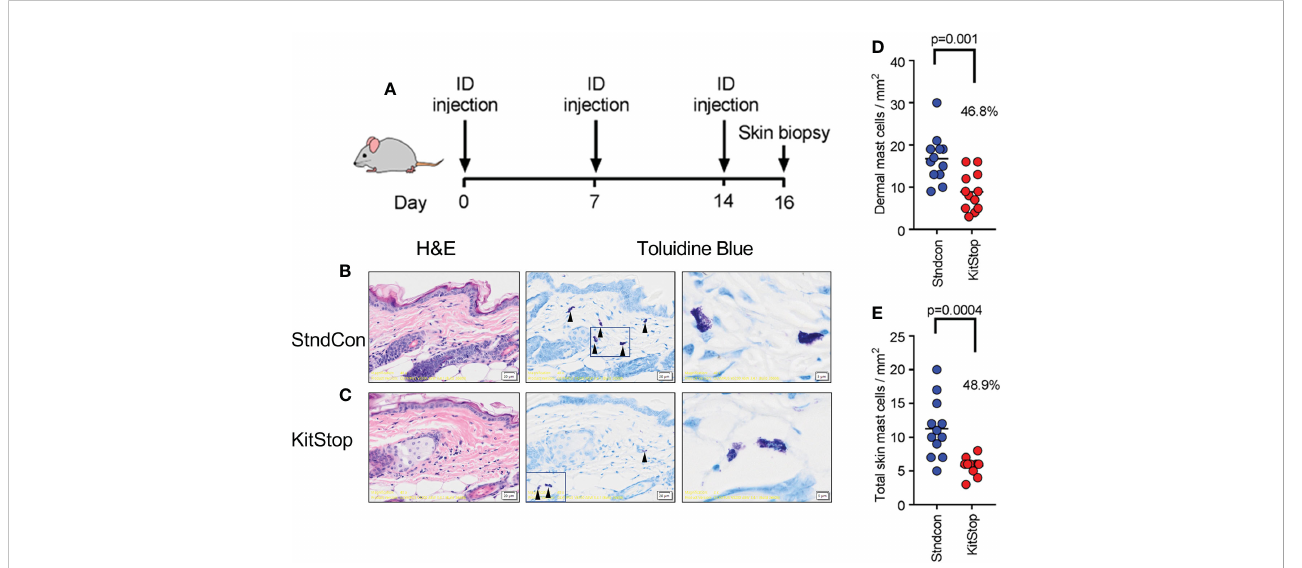
FIGURE 2 Local KitStop ESO administration reduces mouse dorsal skin mast cell numbers in vivo . (A) Four Balb/c mice were given dorsal intradermal injections of either standard control ASO or KitStop ESO every 7 days for a total of 3 injections. Skin was then biopsied 2 days after the fi nal injection for histological analysis. (B, C) In representative sections from standard control ASO (Stndcon; B ) and KitStop ESO (C) treatment groups, MCs were easily identi fi ed due to the presence of positive-staining metachromatic granules, which give a deep violet hue (see red arrow heads). Mast cells displayed normal tissue localization with no evidence of pathology. (D) Plot of dermal mast cell number per mm2 from toluidine blue stained skin sections taken from standard control ASO (blue) or KitStop ESO (red) treated skin. (E) Plot of mast cell number per mm2 from the full thickness skin sections, including dermis and panniculus adiposus surrounding adnexal structures. Each dot represents the average mast cell number per entire specimen. Three specimens were evaluated from each mouse. P values are from an unpaired